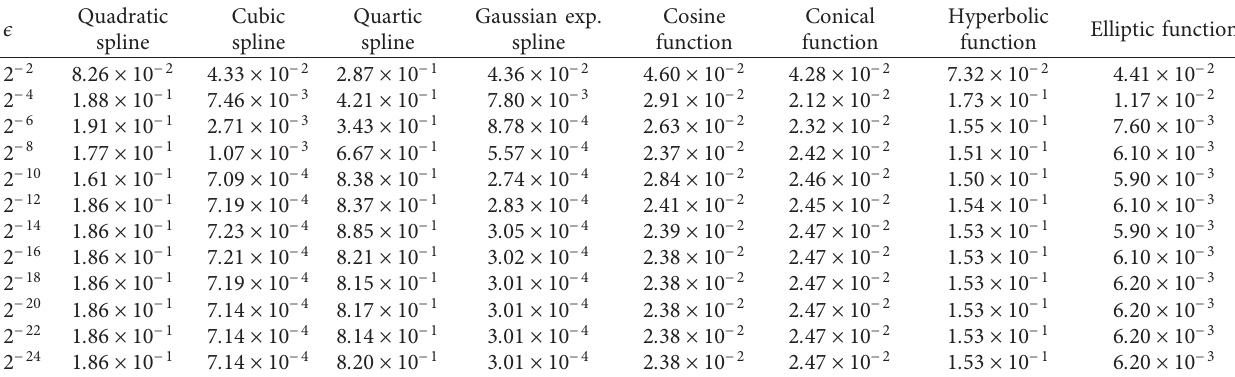
Table 6: Maximum absolute errors for Example 2 for different values of ϵ with quadratic basis functions.